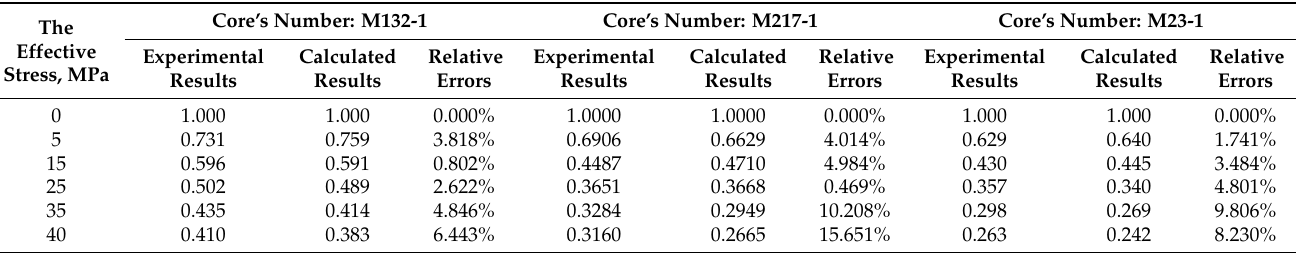
Table 3. The comparison between the dimensionless permeability calculated by the proposed model and that found in experiments by Zhong et al. [49].